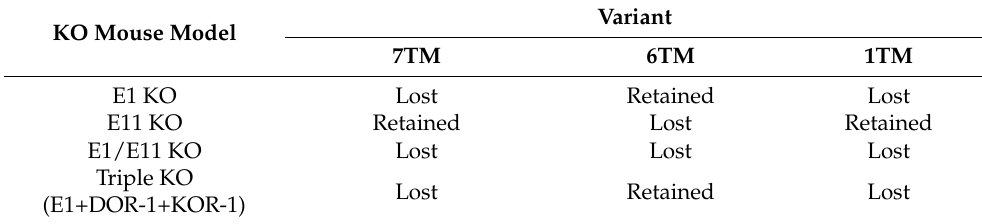
Table 4. Oprm1 KO mouse